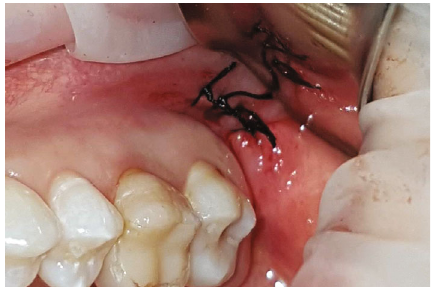
Figure 6: Simple suture in donor site with 4.0 silk